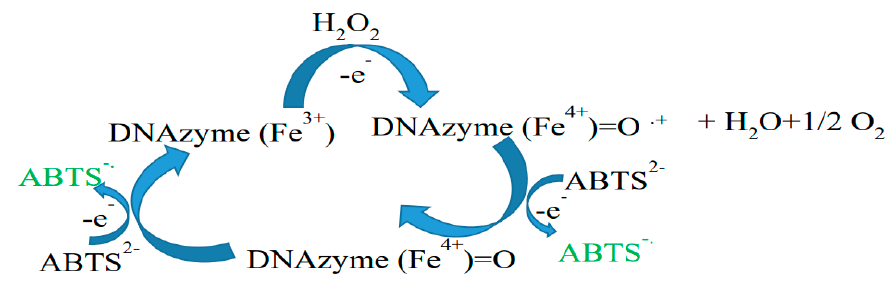
Figure 8. The mechanism of oxidation of ABTS 2– by DNAzyme.